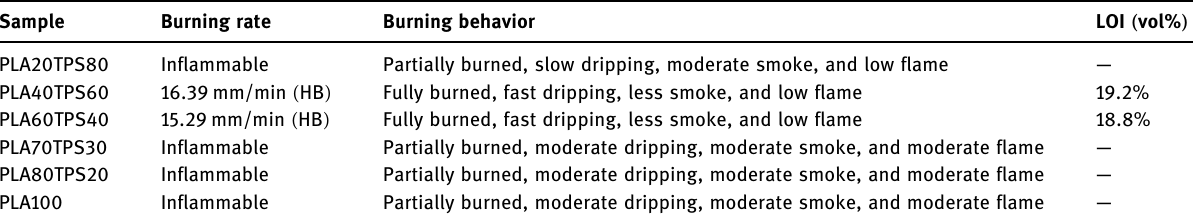
Table 4: Burning rate, UL94 rating, and burning behavior of pristine PLA and PLA/TPS blend bionanocomposites Sample Burning rate Burning